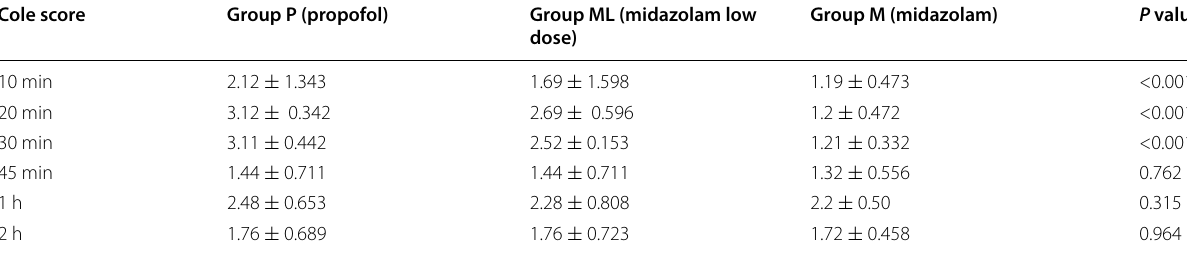
Table 4 Cole agitation score in the postoperative period